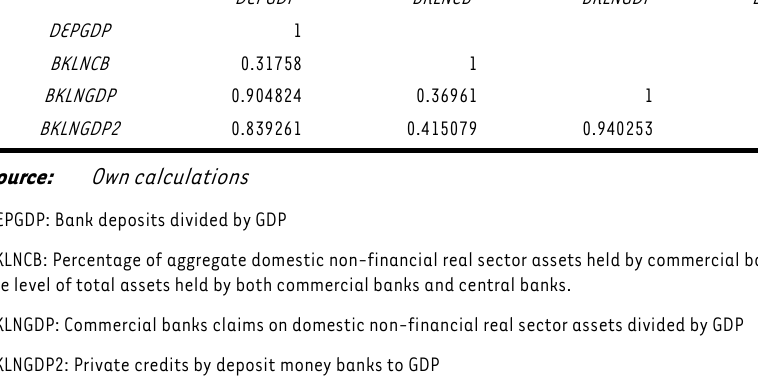
Principal Components